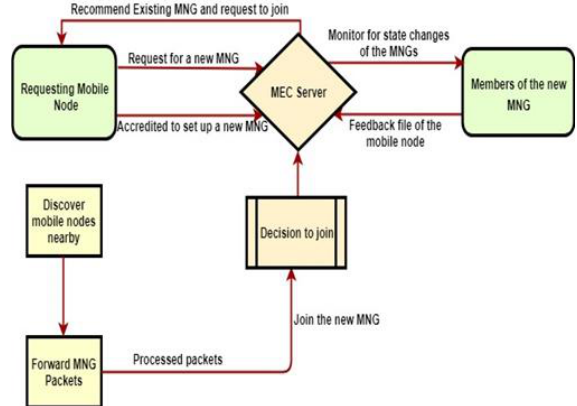
Figure 1. MNG networking adopting